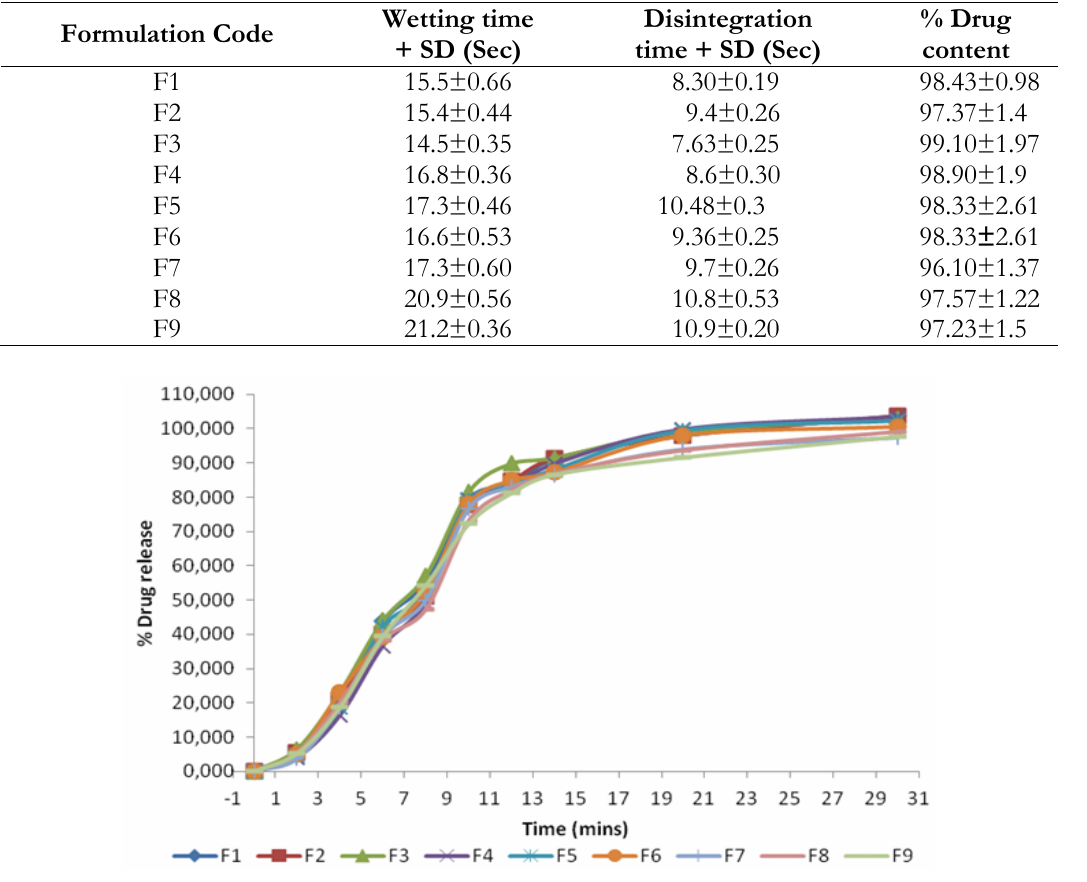
Table VII. Evaluation of post-compression parameters of fast dissolving tablets Formulation Code